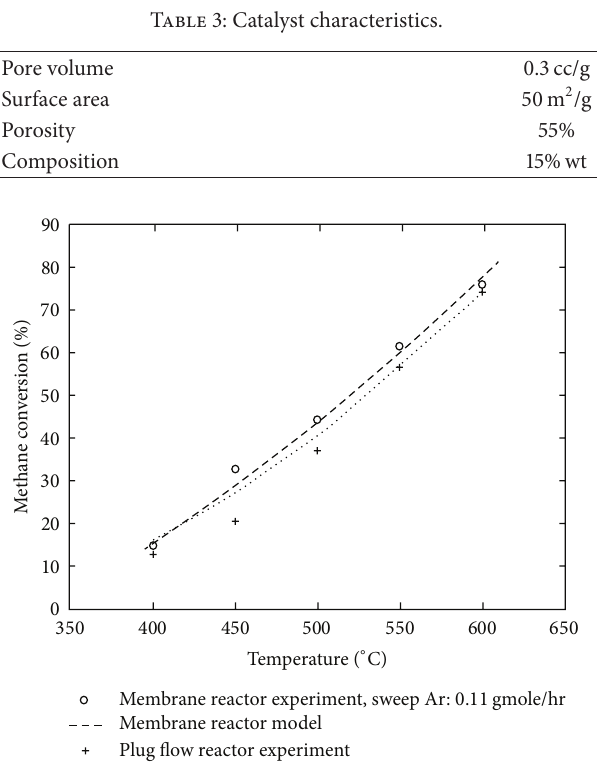
Figure 1: Experimental and modeling results of landfill gas-steam reformers for syngas production and SOFC continuous operation. = 1.68 atm, space time = Total methane conversion data ( 𝑃 𝑇 𝑜 ). 48.0 g cat ⋅ hr/gmole CH4